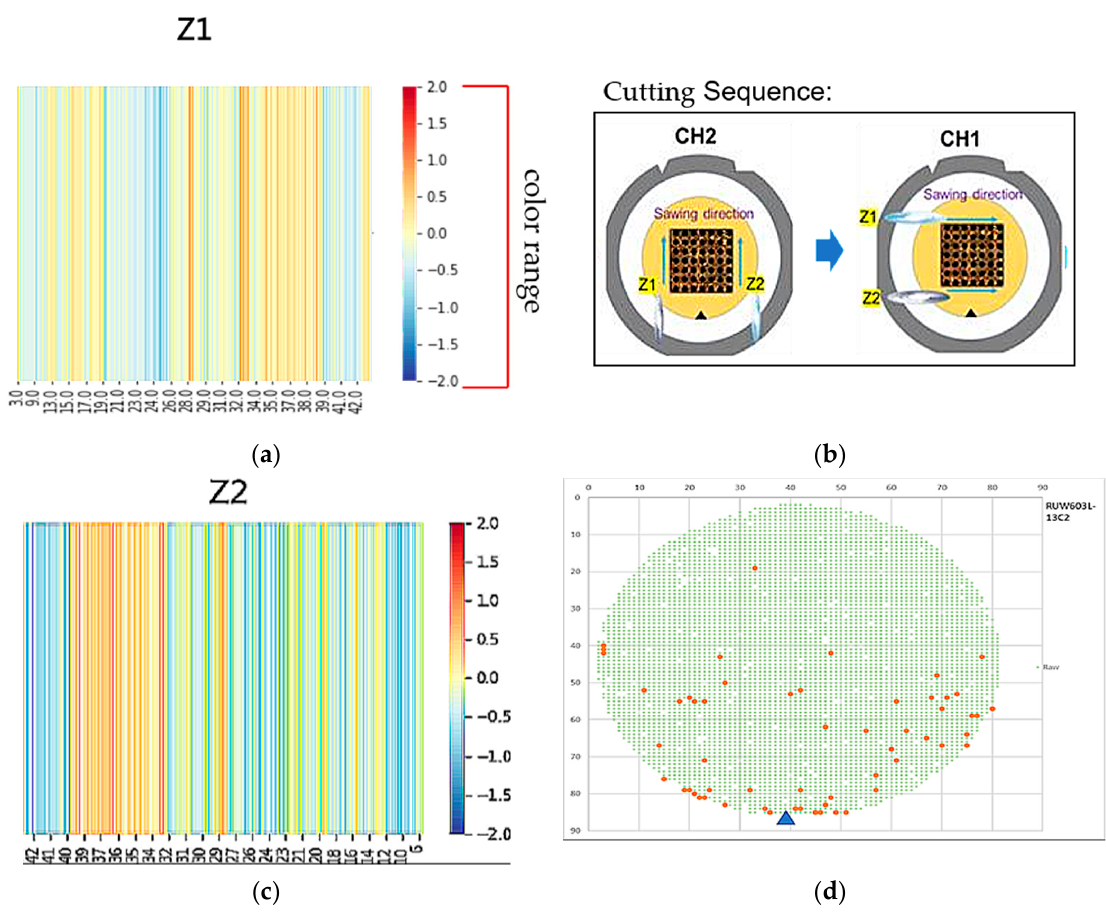
Figure 17. Heat map after PCA dimensionality reduction where ( a ) Heat map of kerf Z1; ( b ) Cutting Sequence; ( c ) Heat map of kerf Z2 in which arrows represent sawing direction; ( d ) Wafer chipping coordinate of ID: RUW603L_13C2 in CH2 in which a triangle symbol represents the kerf Z1 stopped location.